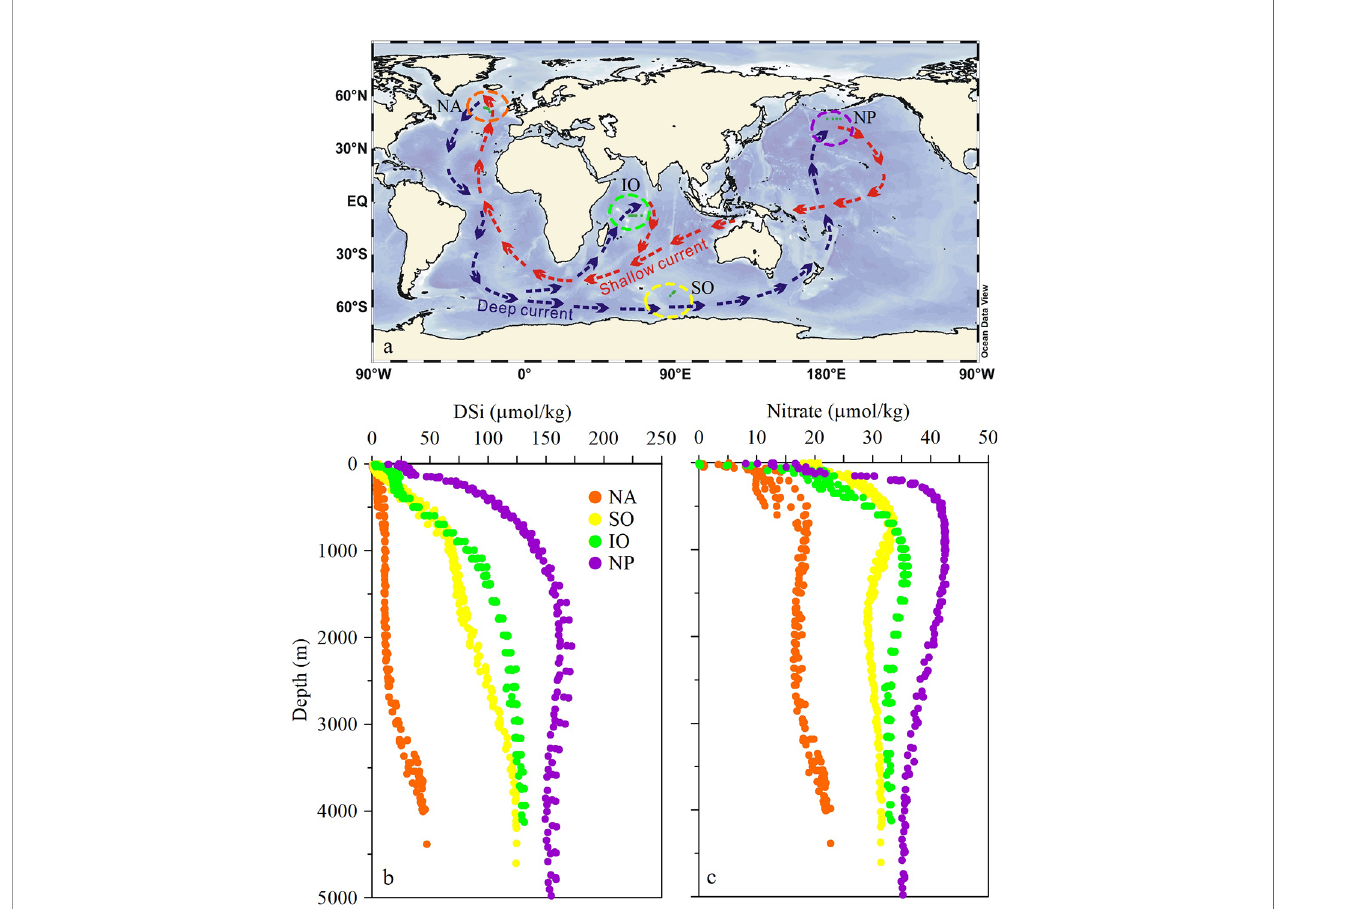
FIGURE 1 | Distribution of DSi and nitrate concentrations ( m mol/kg) in the open oceans at different stages of the global ocean conveyor belt. (A) Schematic map of the global ocean conveyor belt (after Lozier, 2010); blue and red arrows indicate deep and shallow currents, respectively. Vertical distributions of (B) DSi and (C) nitrate concentrations in the study areas in the North Atlantic (NA), Southern (SO), Indian (IO), and North Paci fi c (NP)